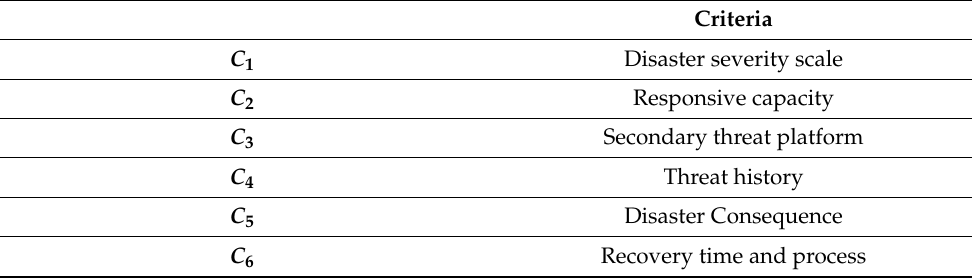
Table 4. Research